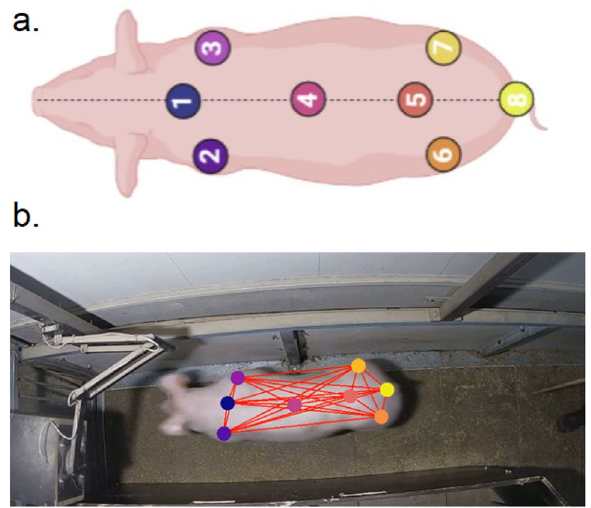
Figure 2. ( a ) Schematic overview of the eight body positions annotated for pose configuration in DeepLabCut 27 (created with BioRender.com). 1 = Spine1; 2 = Shoulder left; 3 = shoulder right; 4 = Center; 5 = Spine2; 6 = Hip left; 7 = Hip right; 8 = Tail base. ( b ) Example of a labeled pig during weighing using the DeepLabCut